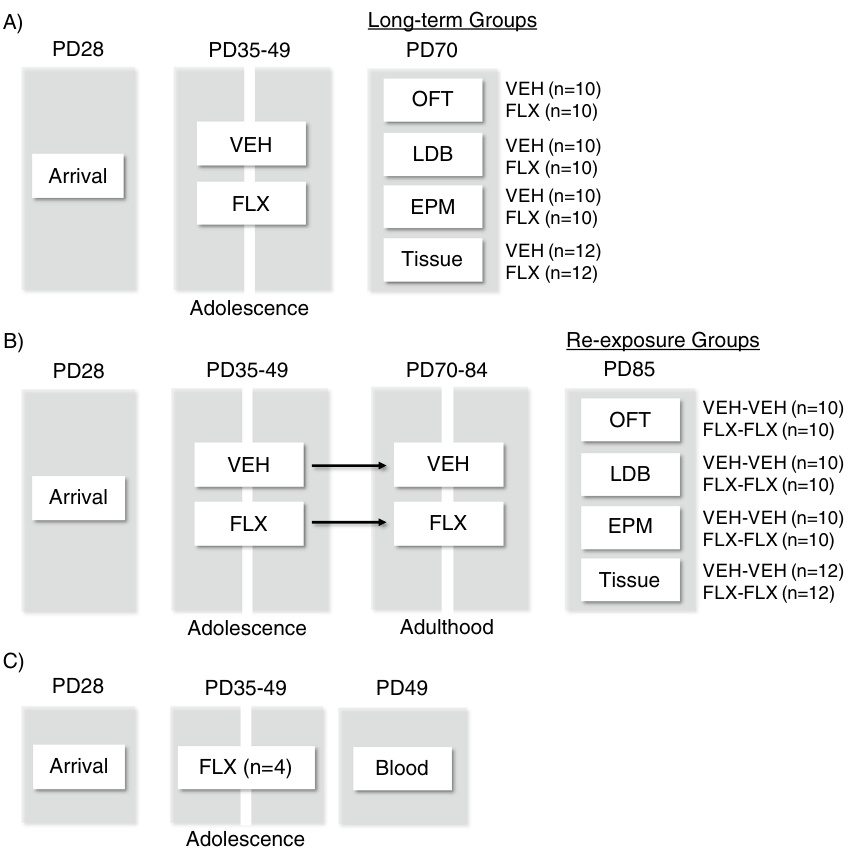
Figure 1. Timeline of juvenile fluoxetine (FLX) treatment and experimental procedures. ( A ) Postnatal day (PD)-28 female C57BL/6 mice arrived to our animal colony. One week later (PD35), they were randomly assigned to receive FLX in their drinking water (250 mg/l) for 15 consecutive days (PD35-49), or water alone (vehicle, VEH). After a 21-day washout period (PD70), separate groups of mice were tested on the open field test (OFT), light/dark box (LDB), elevated plus maze (EPM), or euthanized for tissue extraction (Long-term groups). ( B ) Separate groups of PD28 mice arrived to our animal colony. One-week later (PD35) they were exposed to VEH or FLX in their drinking water (PD35-49). After a 21-day washout period (PD70), FLX or VEH was re-administered for two additional weeks (PD70-84). Twenty-four h after FLX or VEH re-exposure (PD85), mice were either tested on the OFT, LDB, EPM, or euthanized for tissue extraction (Re-exposure groups). ( C ) Blood was collected from a separate group of animals on PD49 to evaluate serum FLX concentrations after exposure to FLX in their drinking water for 15